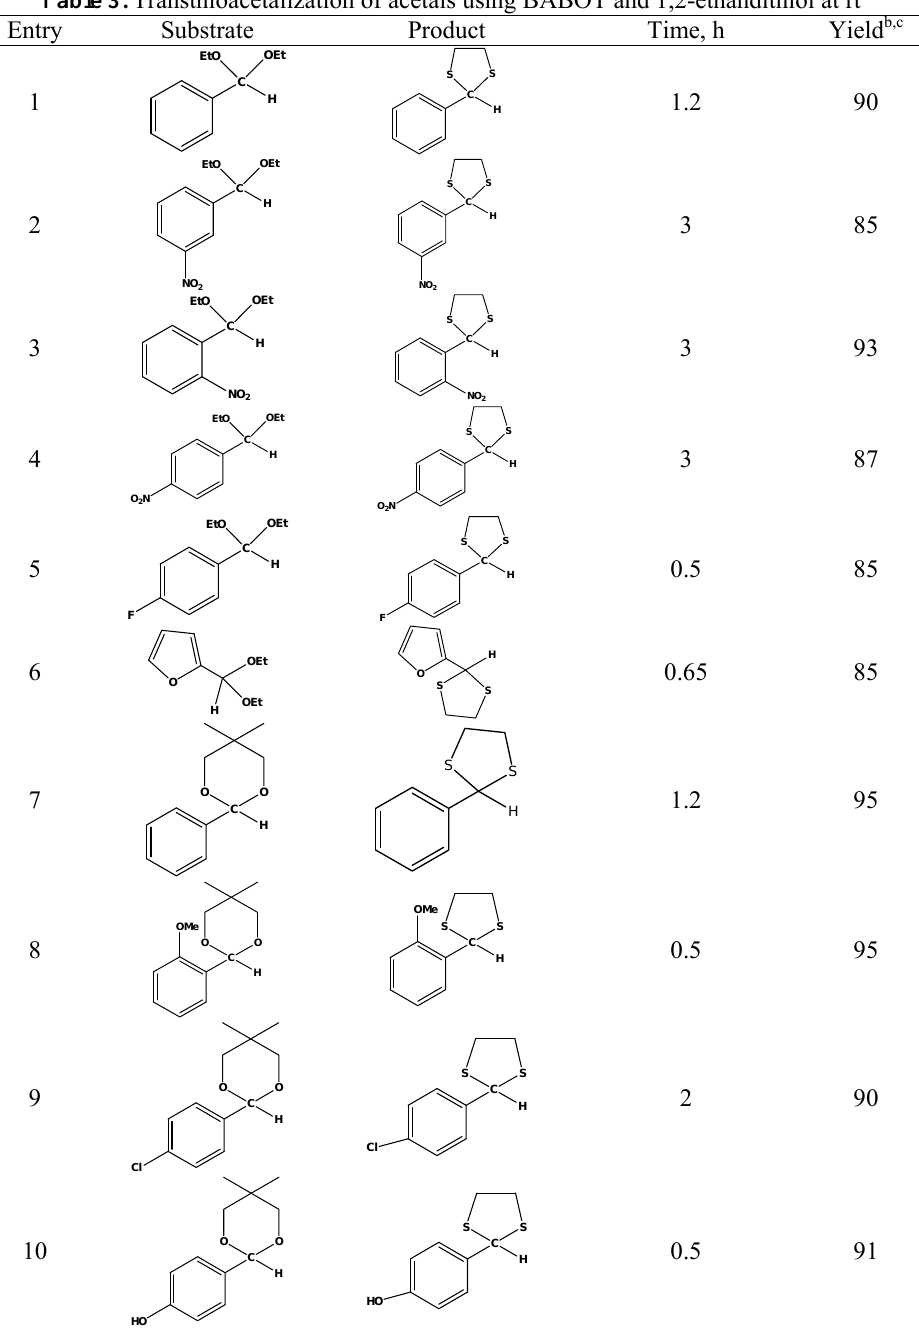
Table 3. Transthioacetalization of acetals using BABOT and 1,2-ethandithiol at rt